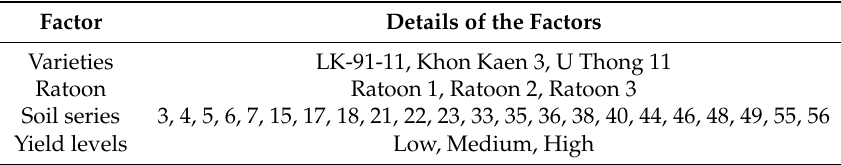
Table 1. Environmental factors of sugarcane plantation in